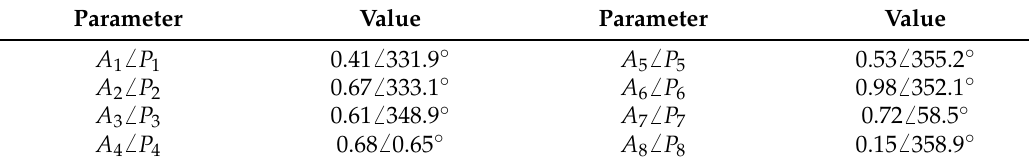
Table 3. Optimized Feeding Weights.